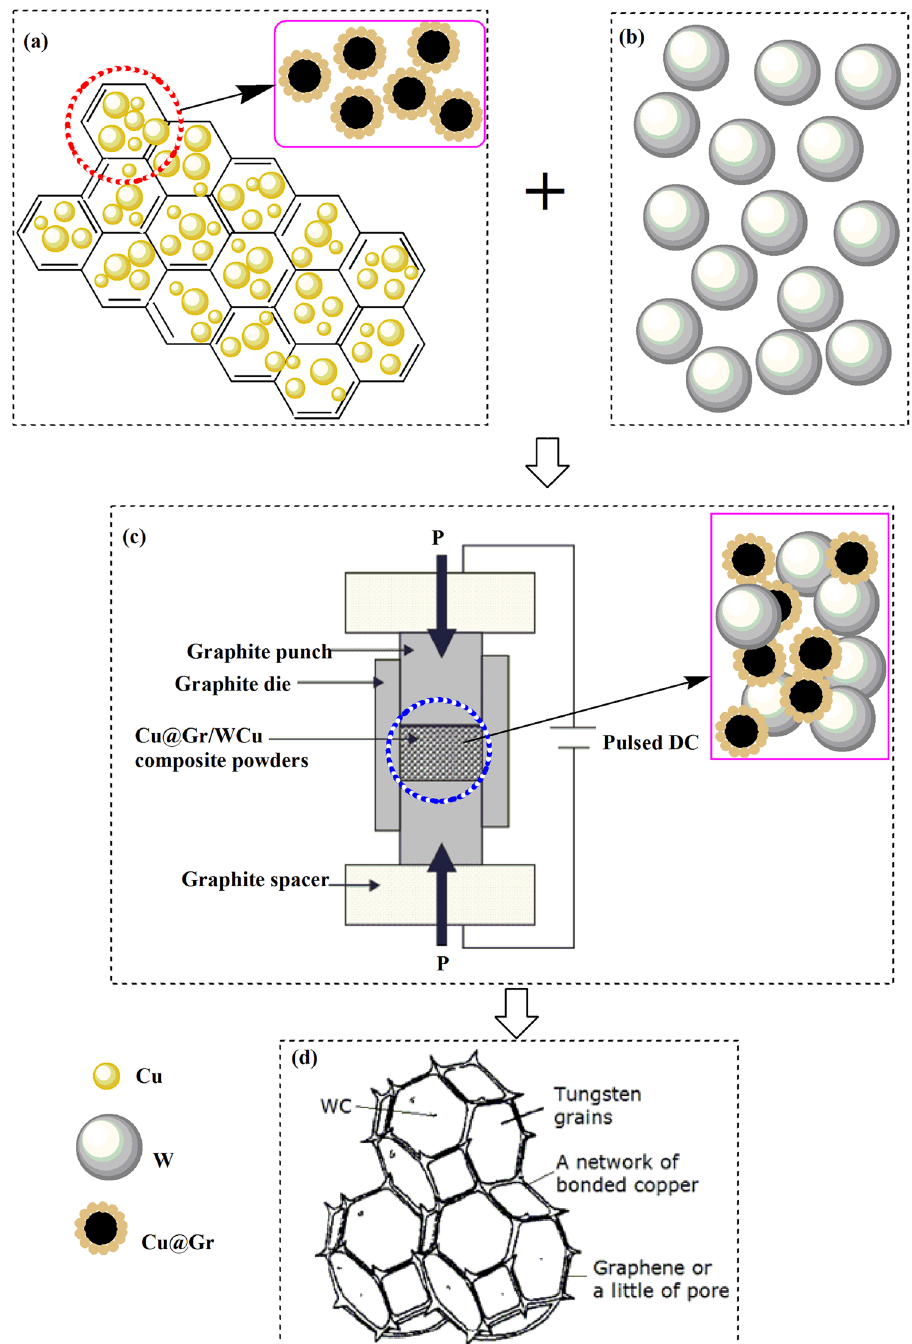
Figure 5. Diagram illustrating the proposed mechanism of coated powders during spark plasma infiltrating concentrated on the surfaces of particles (W and Cu@Gr) during sintering. The DC pulsing cycles preserve the charge accumulated at the particle surfaces, thereby generating spark discharges and joule heat among particles. The DC current causes rapid and uniform distribution of the heat throughout the powder com- pact, enhancing homogeneity of microstructure and uniformity of density. The Joule’s heating and applied pressure are responsible for the enhanced diffusion and mass transport during sintering. Finally, the Cu@ Gr particles can form a network type and effectively fill the gaps among the W particles. The significant grain growth could be prevented due to the shorter holding time and applying of the external pressure during the SPS 28 . All these cause the necks to be gradually developed and the grain size to be increased, thus resulting in a rapid densification sintering.